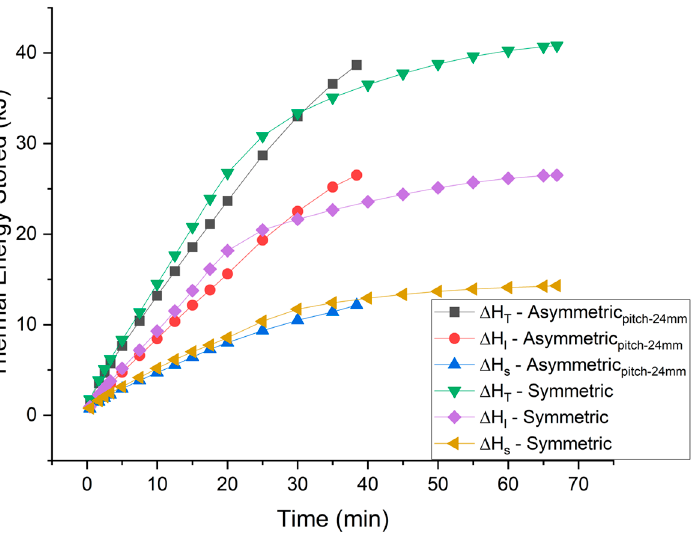
Table 2. Longitudinal position of the highest point of the model Model